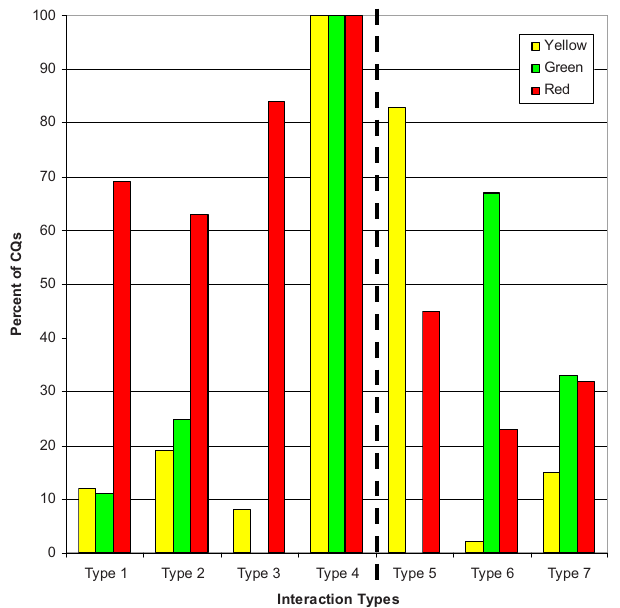
FIG. 3. (cid:1) Color (cid:2) Percent of clicker questions where the professor was observed to engage in each type of faculty-student interaction (cid:1) Types of interactions are defined in Table I (cid:2) . The dashed line de- notes that Types 5–7 at the rightmost side of graph are mutually exclusive